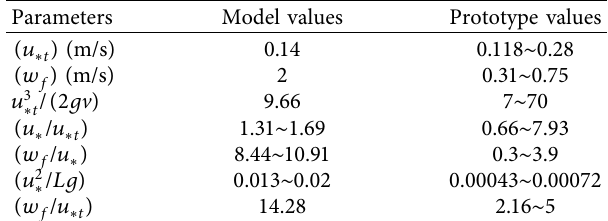
Table 1: Main parameters of the